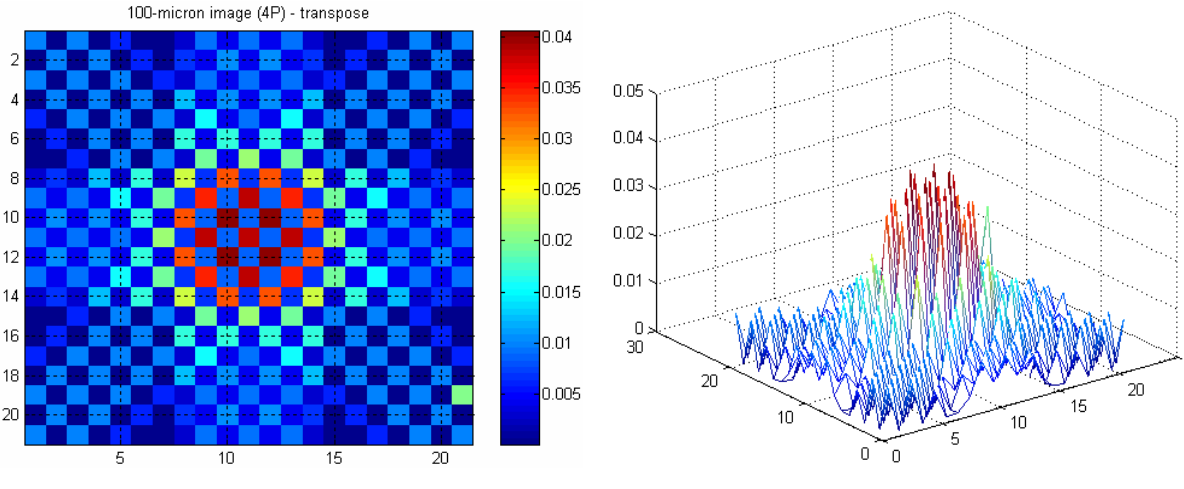
Figure 15. A 100 micron reconstructed image using